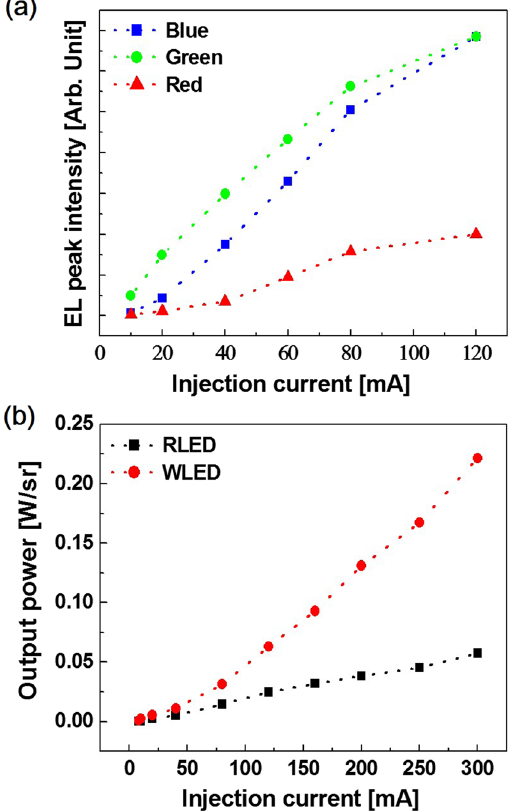
Figure 6. ( a ) Summary of the EL peak intensities for blue, green, and red emissions of the WLED as a function of the injection currents ranging from 10 to 120 mA, and ( b ) the output powers of the LED sample as a function of currents ranging from 8 to 300 mA, wherein the dotted lines are simply visual